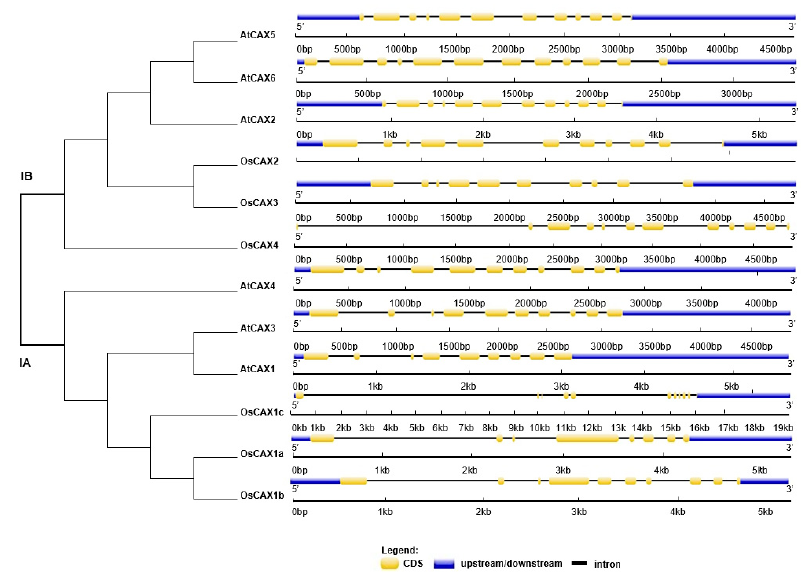
Figure 1. Phylogenetic relationship of CAX family genes of Oryza sativa and Arabidopsis thaliana . The phylogenetic tree was constructed based on sequence alignment of CAX homologs from Arabidopsis (At) and rice (Os), using the neighbor-joining method with bootstrapping analysis implemented in MEGA 7.0. The CAX proteins are clustered into two groups (Type IA and Type IB). Gene struc- tures were drawn, using Gene Structure Display Server 2.0 with genomic sequences and CDS sequences. Introns and exons are represented by black lines and yellow boxes, respectively. Blue boxes represent